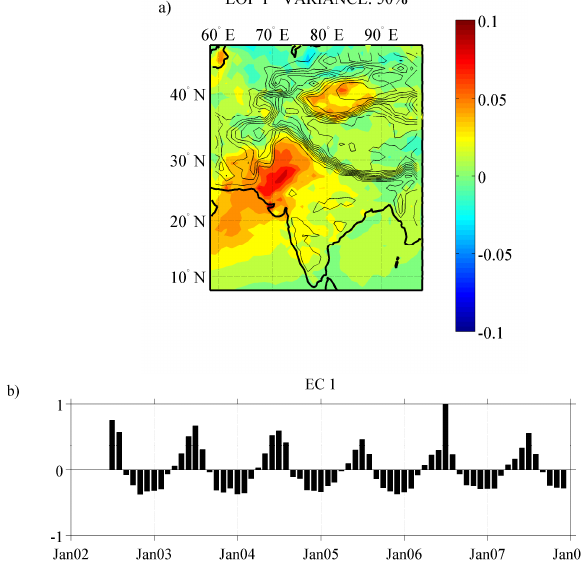
Fig. 3. EOF 1 (a) and EC1 (b) computed from MODIS monthly Figure 3: EOF 1 (a) and EC1 (b) computed from MODIS monthly aerosol optical depth aerosol optical depth (AOD) using the combined product of dark (AOD) using the combined product of dark target approach and deep blue algorithm. [ Terrain target approach and deep blue algorithm. [Terrain contours are plot- ted at 500 m interval from 500 to 8000m. contours are plotted at 500 m interval from 500m to 8000 m.